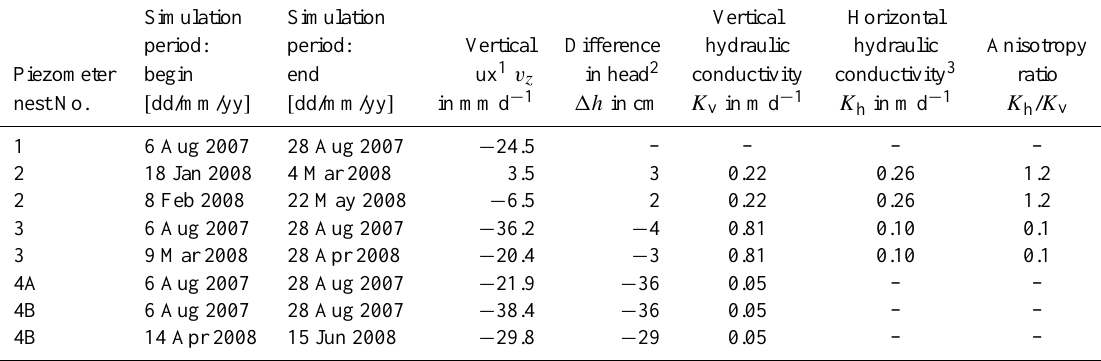
Table 2. Estimated vertical hydraulic conductivity K v using thermal and hydraulic head data. Simulation Simulation Vertical Horizontal period: period: Vertical Difference hydraulic hydraulic Anisotropy Piezometer begin end flux 1 v z in head 2 conductivity conductivity 3 ratio nest No.